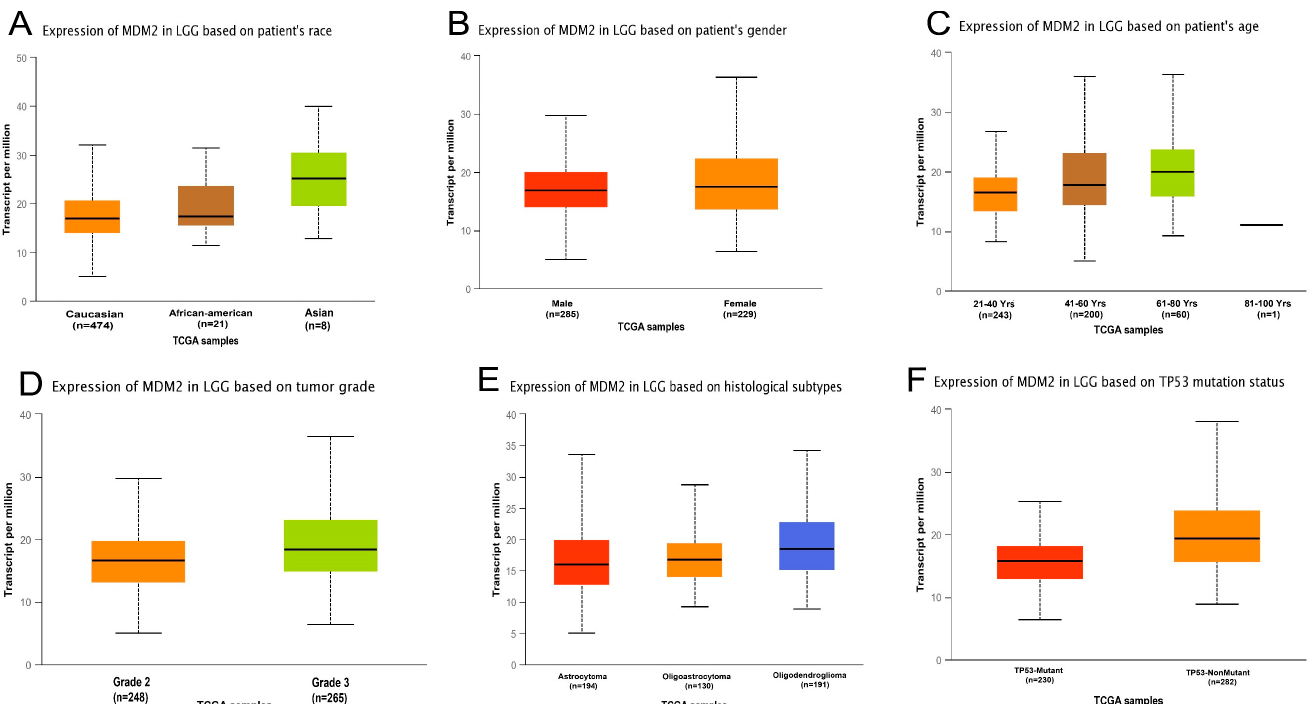
Figure 2. Using the UALCAN database, we analyzed the prognostic significance of the MDM2 gene in TCGA LGG, comparing cancerous and normal stages depending on several characteristics. ( A ) The expression of MDM2 in LGG varies depending on the patient’s race. ( B ) The expression of MDM2 in LGG is dependent on the gender of the patient. ( C ) The expression of MDM2 in LGG is dependent on the patient’s age. ( D ) The expression of MDM2 in LGG depends on the tumor grade. ( E ) The expression of MDM2 gene in LGG cancer based on histological subtypes. ( F ) The expression of MDM 2 in LGG based on the TP53 gene mutation status.